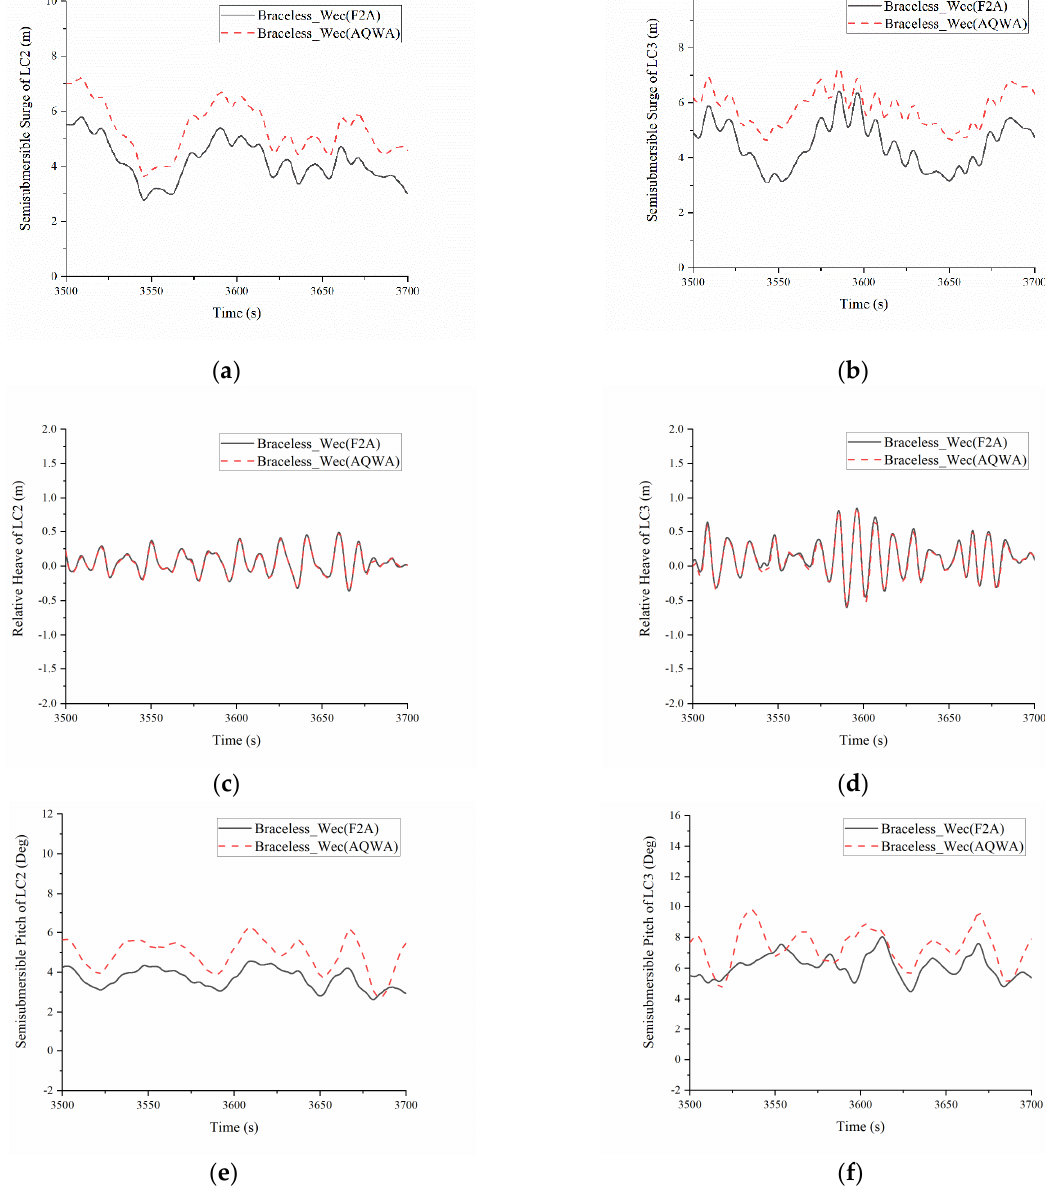
Figure 8. Time domain motion response of the semisubmersible platform: ( a ) Surge in LC2; ( b ) Surge in LC3; ( c ) Relative Heave in LC2; ( d ) Relative Heave in LC3; ( e ) Pitch in LC2; ( f ) Pitch in LC3.